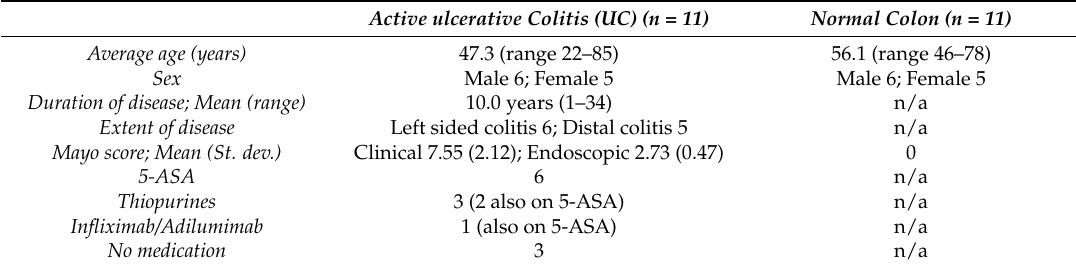
Table 1. Demographic data of patients for paired mRNA and microRNA (miR) analysis. n: number of subjects; n/a: not applicable; St. dev.: standard deviation; 5-aminosalicylic acid: 5-ASA.